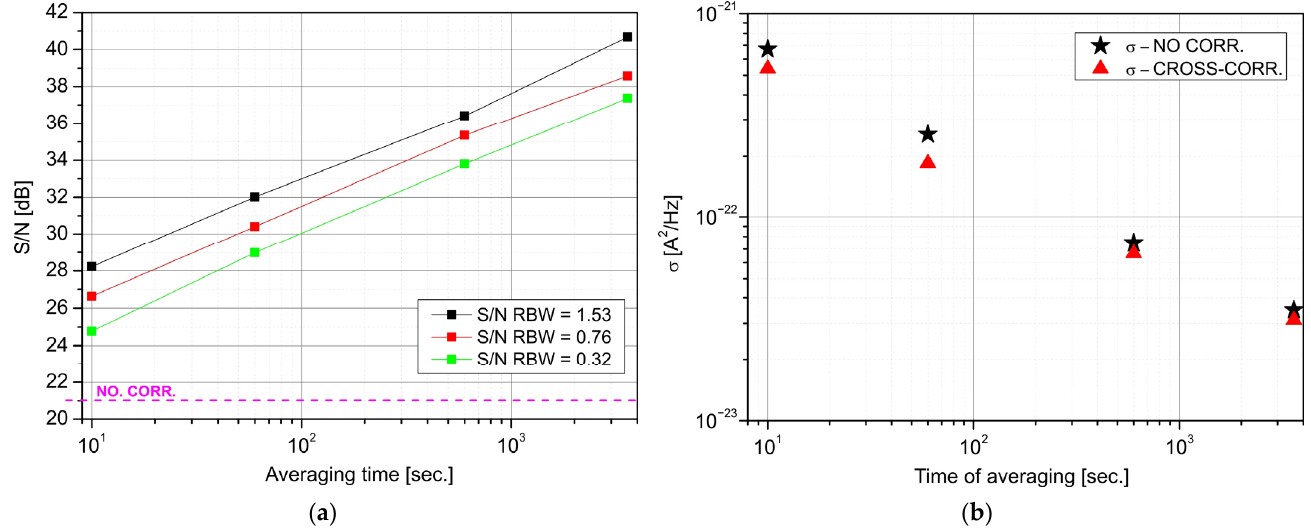
Figure 8. Influence of averaging time on SNR values for different RBWs ( a ) and noise spread (standard deviation) ( b ).